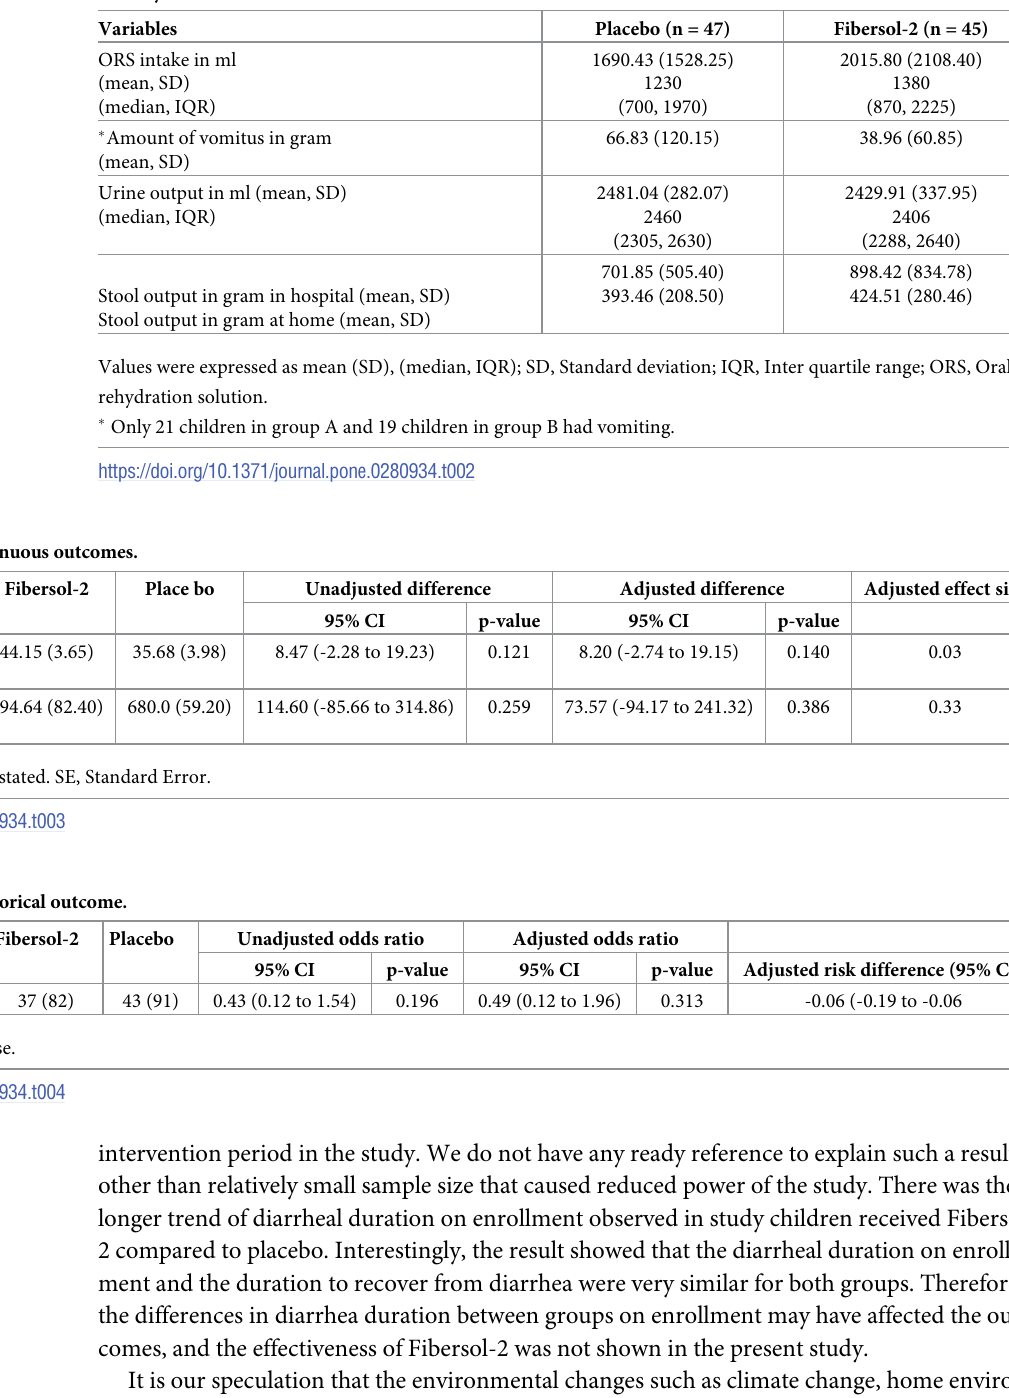
Table 2. Volume of ORS intake, amount of vomitus, urine output and stool output during the intervention period of 7 days.